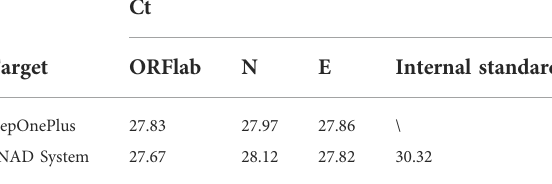
TABLE 5 Ct value of different targets of SARS-CoV-2 from the PAND system and StepOnePlus system.